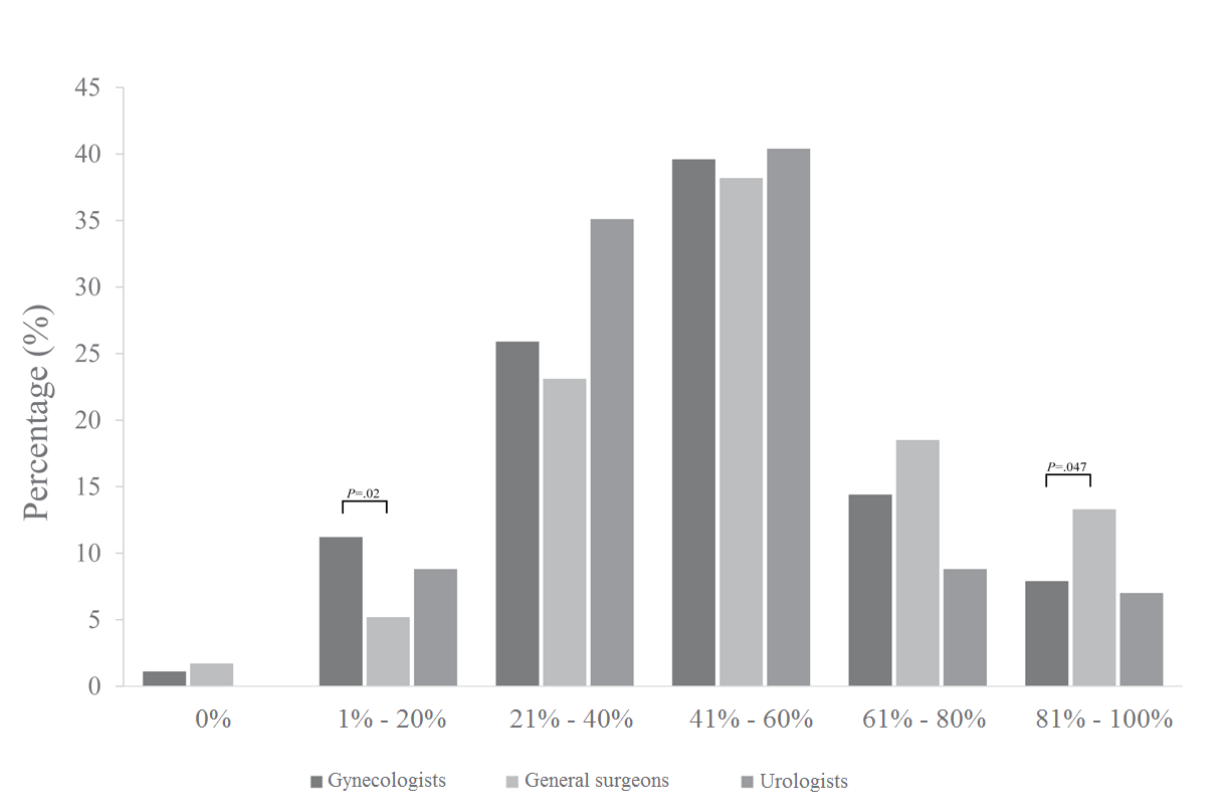
Figure 3. Expectations about how much an artificial intelligence–based surgical assistant system can replace the existing